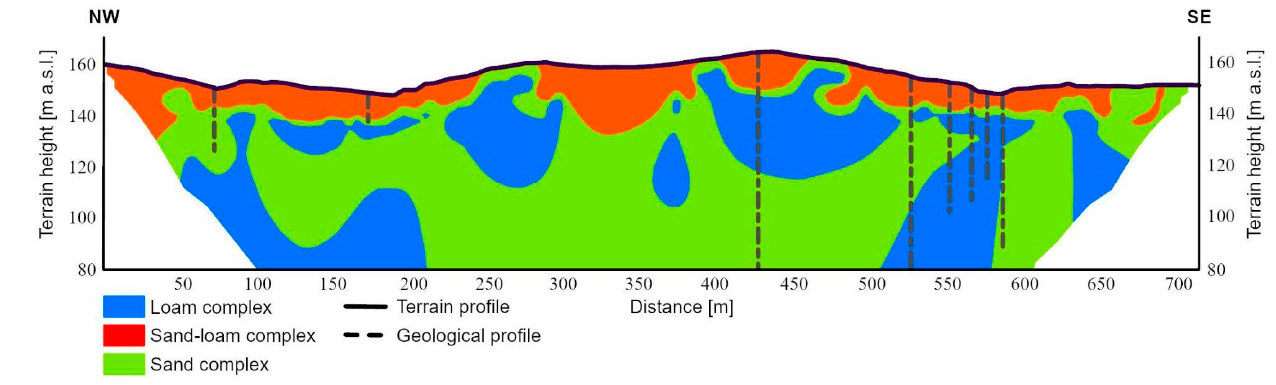
Figure 8. Exemplary geoelectrical profile with geophysical interpretation. Table 1. Lithological and physic-mechanical classification of resistance complexes in the study